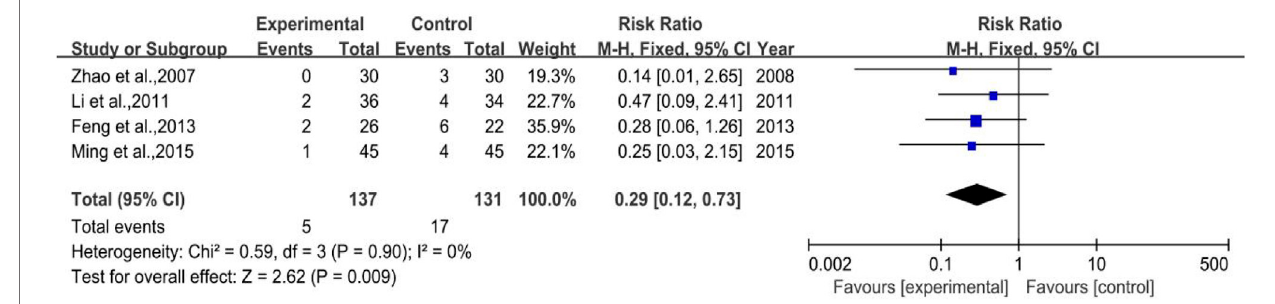
FIGURE 15 | The forest plot of III-IV degree white blood cell suppression rate in therapeutic medication.